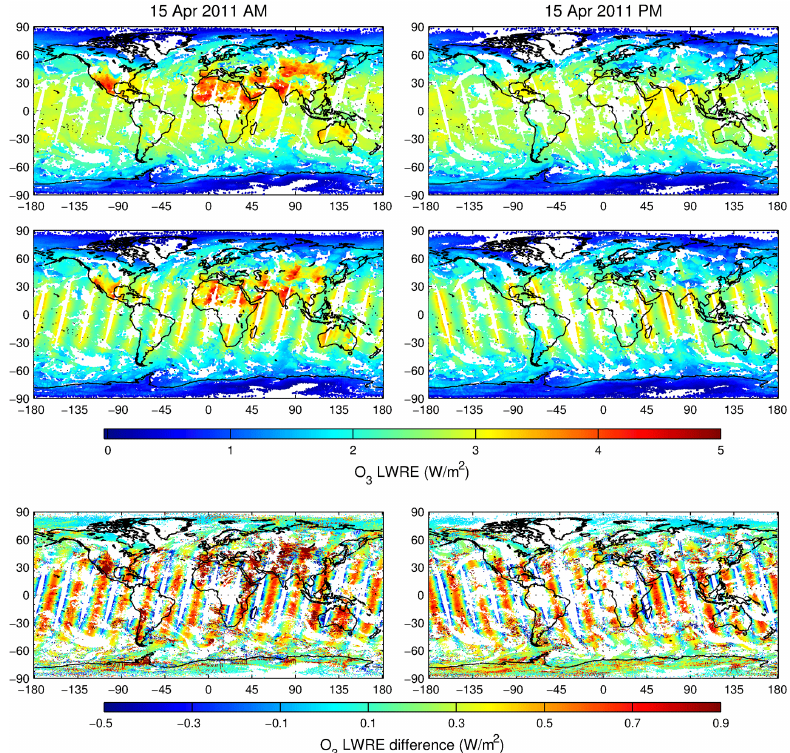
Figure 4. Global distribution of the total O 3 LWRE for morning (left) and evening (right) overpasses of IASI, on 15 April 2011. (top) Calculation using the direct integration method, (middle) calculation using the anisotropy approximation and (bottom) the difference between the two